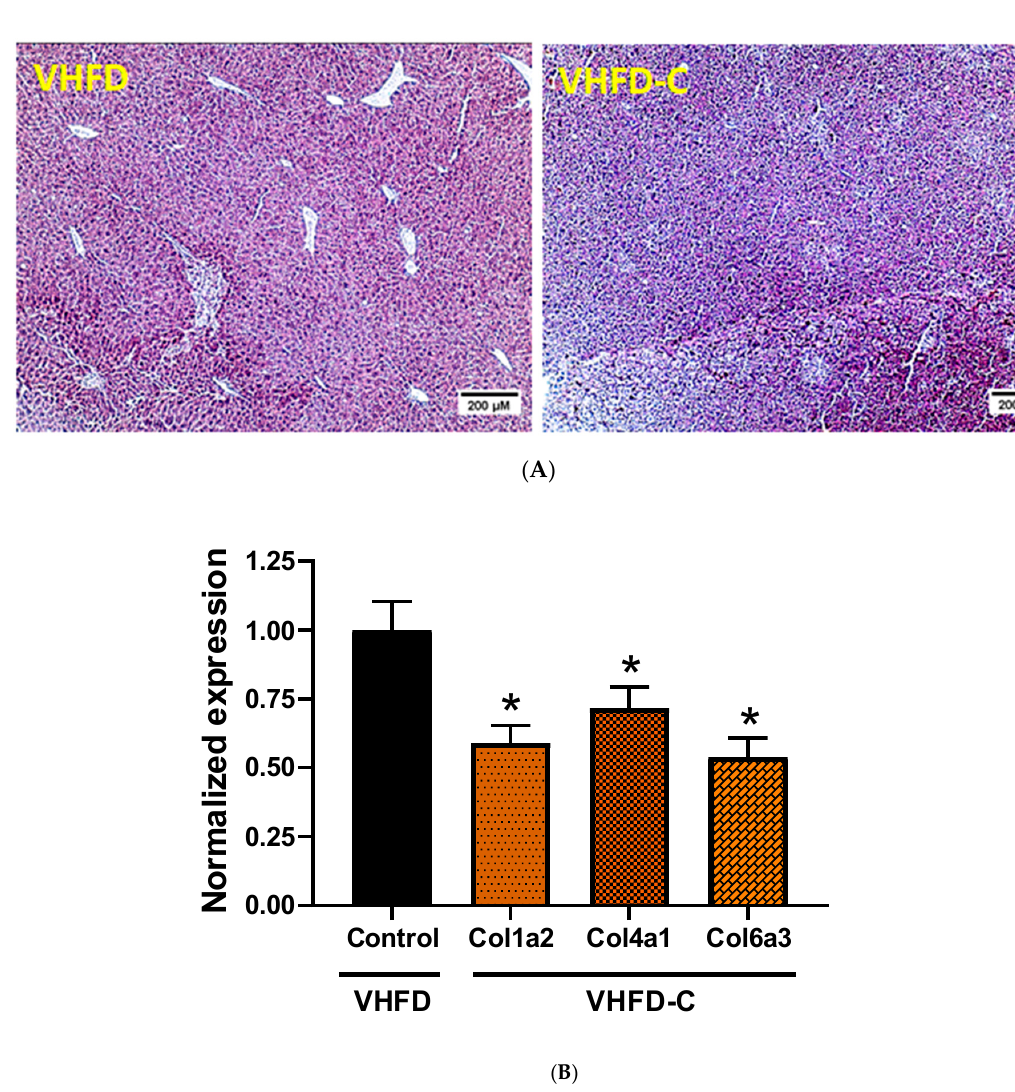
Figure 6. Effects of curcumin on manifestations of fibrosis in mouse liver. ( A ) Photomicrograph of depicting collagen accumulation in the liver. Representative images of Trichrome Stains (Masson) sections. Magnification 100×; n = 4. ( B ) Expression of collagen genes in curcumin-fed animals compared to control group. Target gene expression is normalized to TATA box binding protein gene. * indicates a significant difference at p value ≤ 0.05. p value 0.010, 0.047 and 0.007 respectively; n = 5–6.